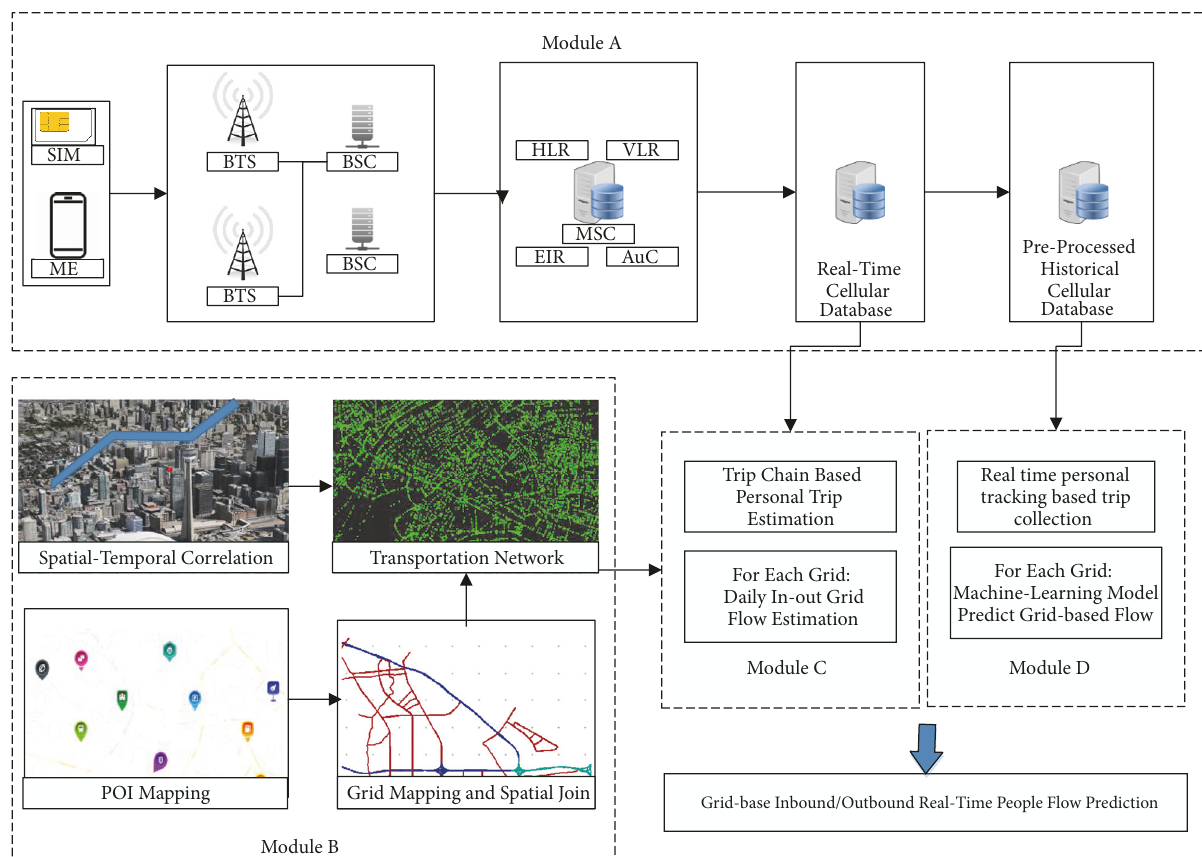
Figure 1: System architecture of people-flow prediction